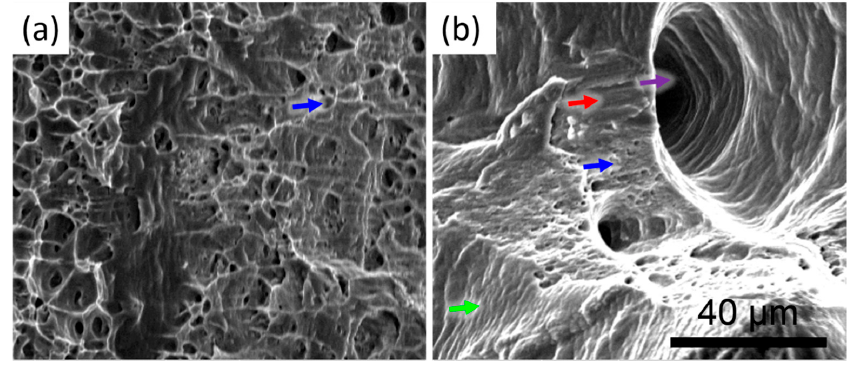
Figure 8. SEM images showing the fracture surface of the tensile aluminum specimens: ( a ) annealed; ( b ) LFP-X. The red, green, blue, and purple arrows represent quasi-cleavage, slip regime, dimple, and elongated pore, respectively.